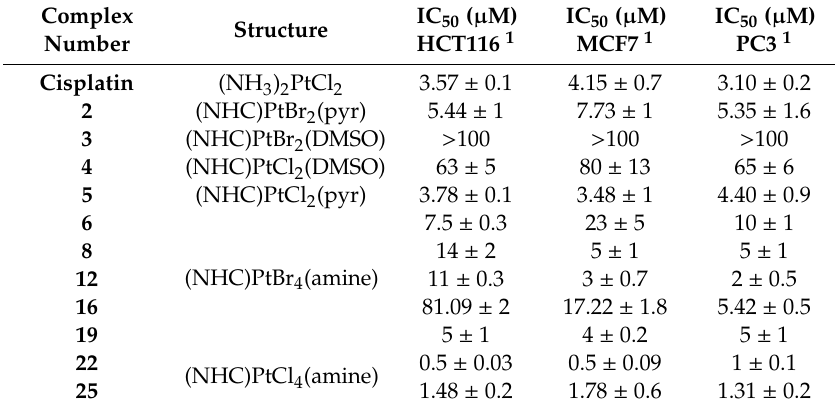
Table 1. Half-inhibitory concentrations IC 50 ( µ M) of the selected complexes toward the HCT116, MCF7 and PC3 cancer